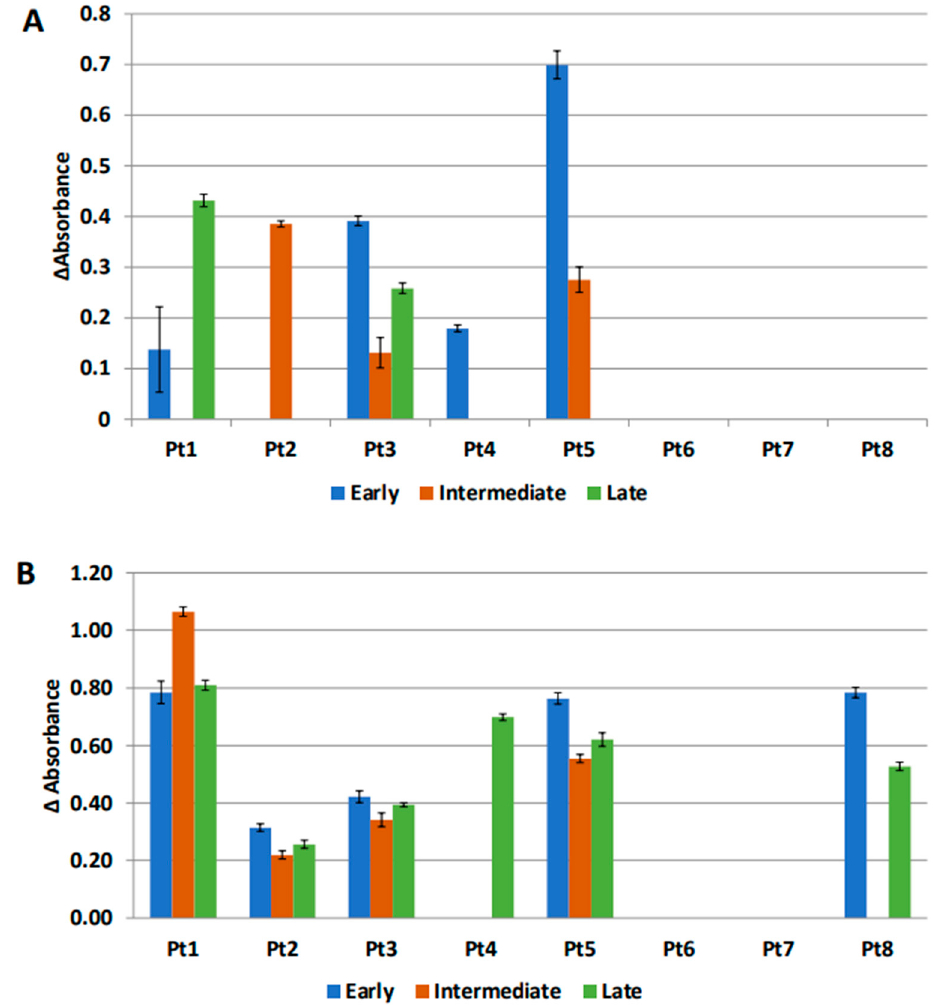
Figure 6. MUC1 IgM absorbance by ELISA in IP fluid ( A ) and plasma ( B ). Samples from eight patients (Pt1-Pt8, x axis) were collected at early (blue), intermediate (red), and late (green) time points. Values on the y axis were calculated as the mean difference between the experimental and background absorbance for each sample. Samples were run in triplicate and bars represent standard deviations. Negative absorbance values are denoted as zero absorbance.